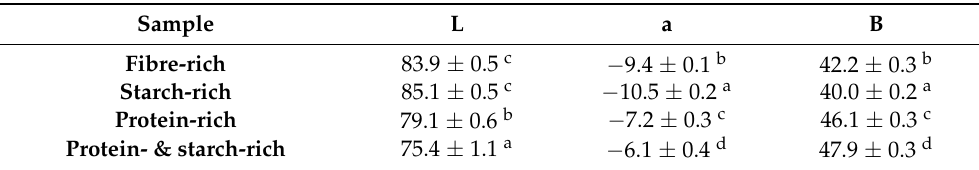
Table 4. L*a*b* colour values of cubes made from the different inks (L: lightness; a: red/green value; b: blue/yellow value).